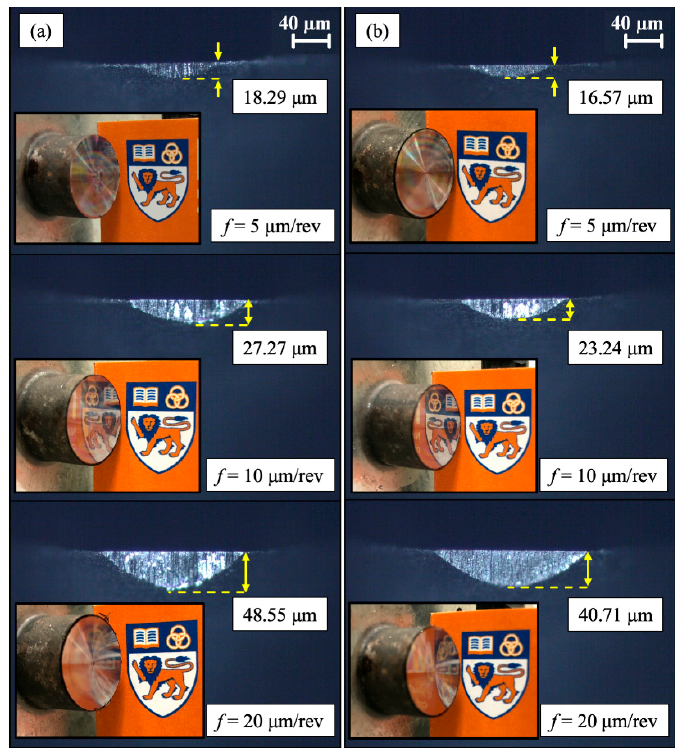
Figure 6. Diamond cutting tool flank wear and the corresponding machined surface quality of iron after cutting a total distance of 50.66 m under different feeds: ( a ) conventional; and ( b ) with the mechanochemical effect.